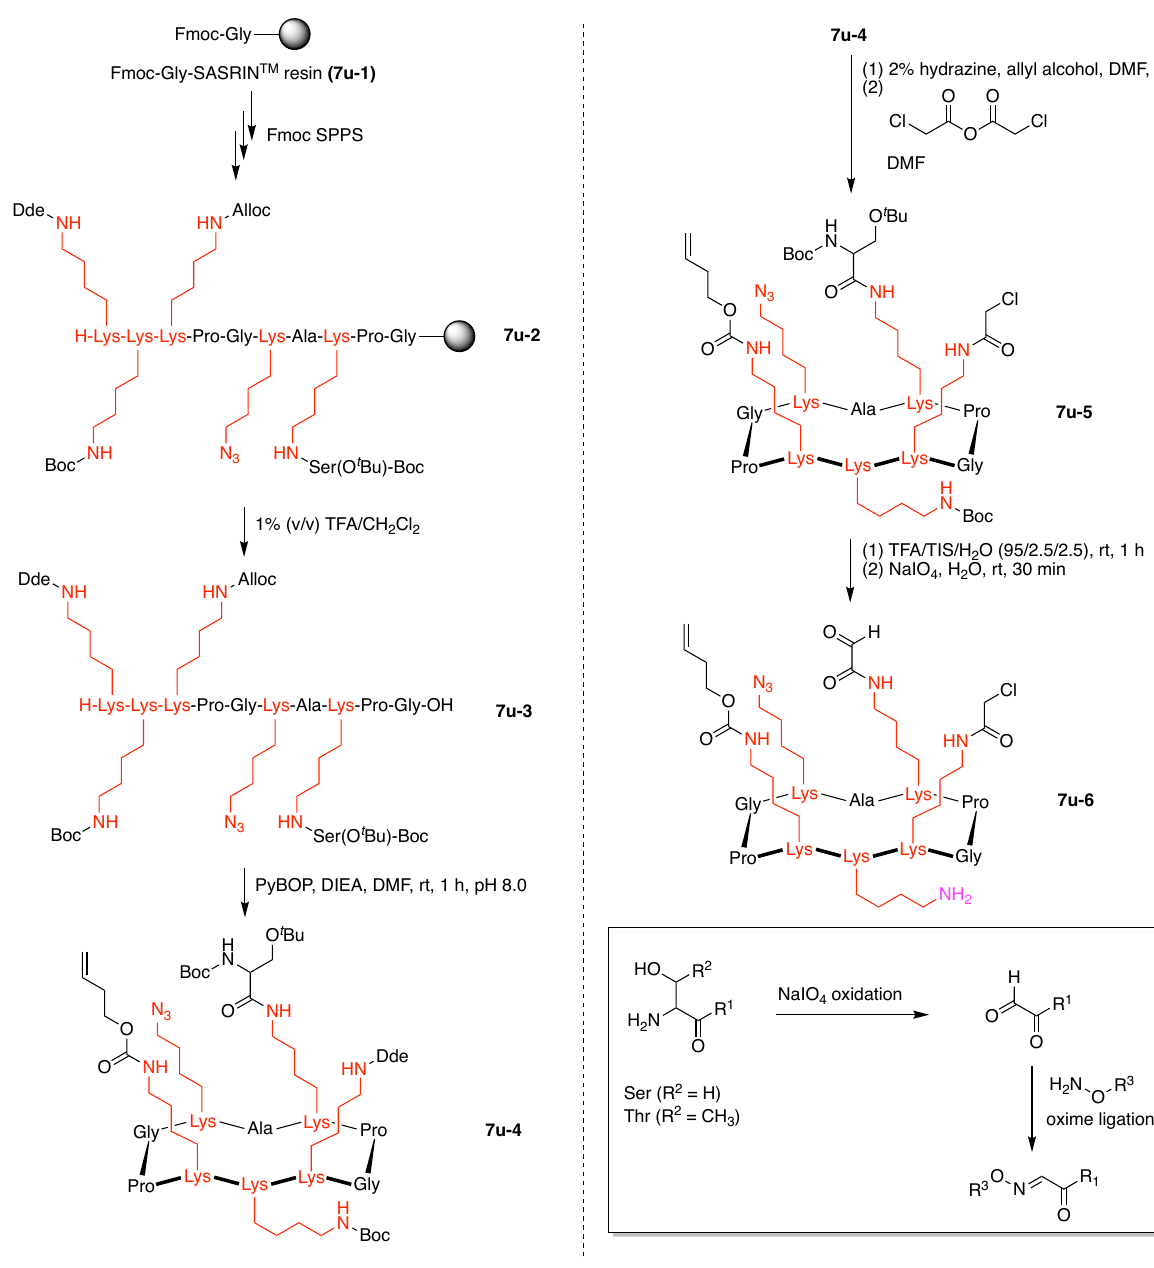
Figure 22. Synthesis of a cyclic decapeptide.